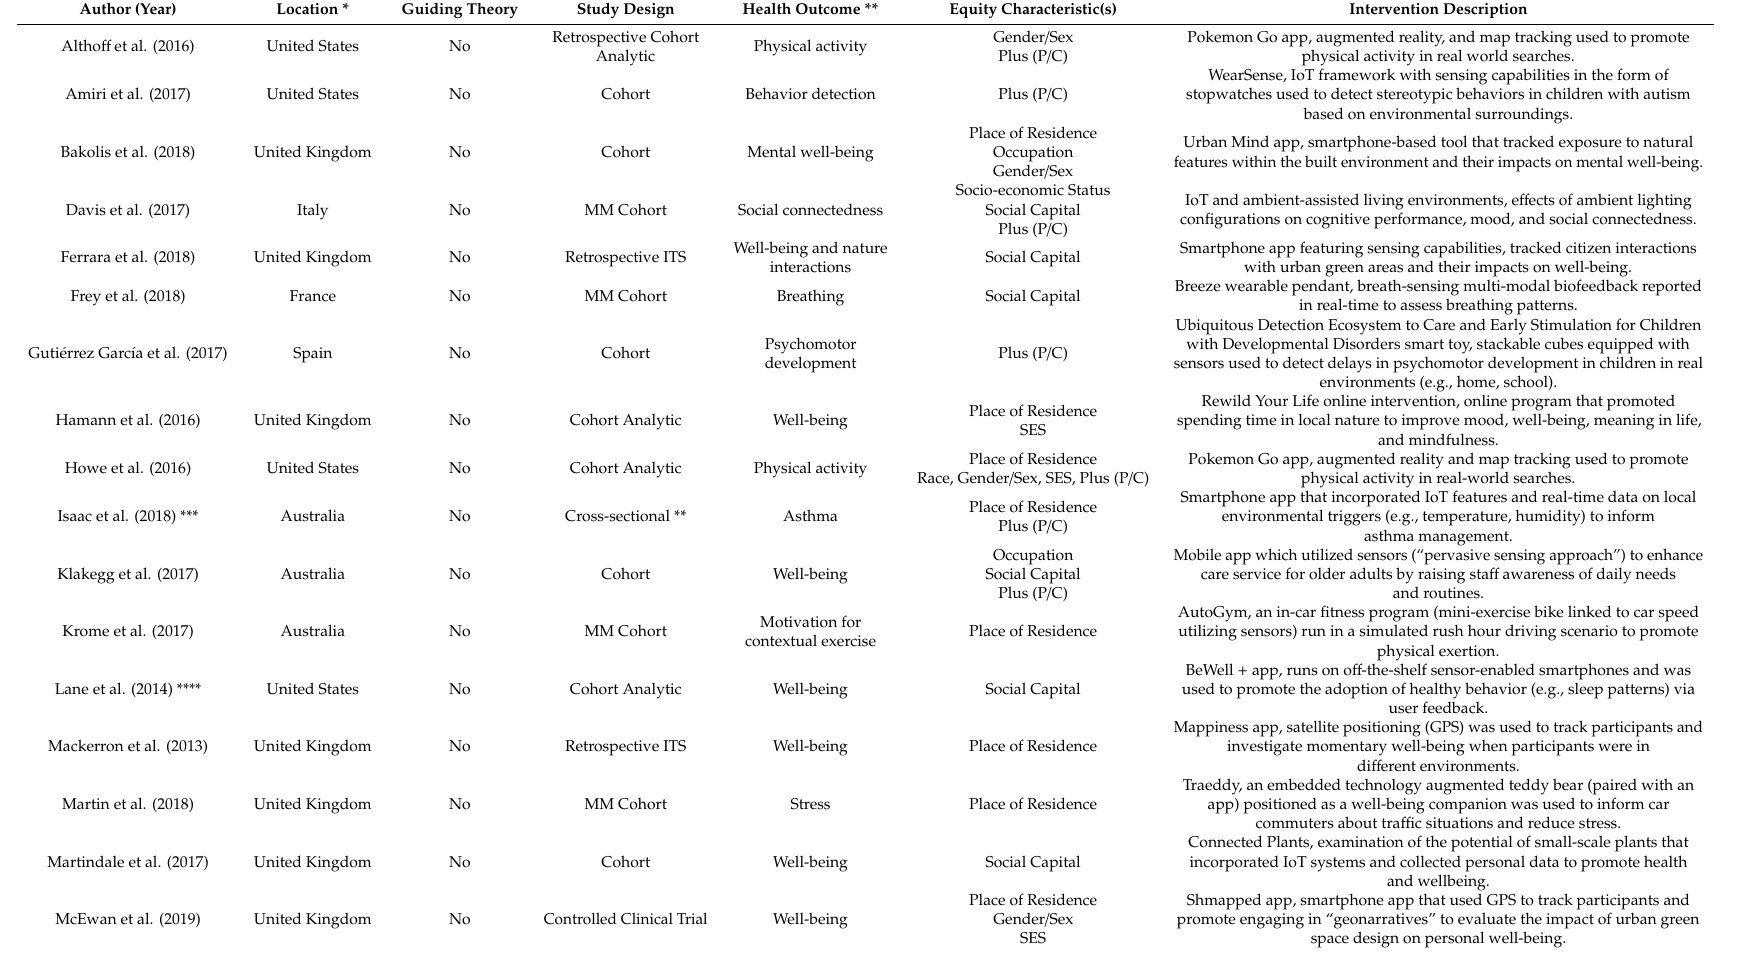
Table 3. General characteristics of included studies in systematic review ( n =